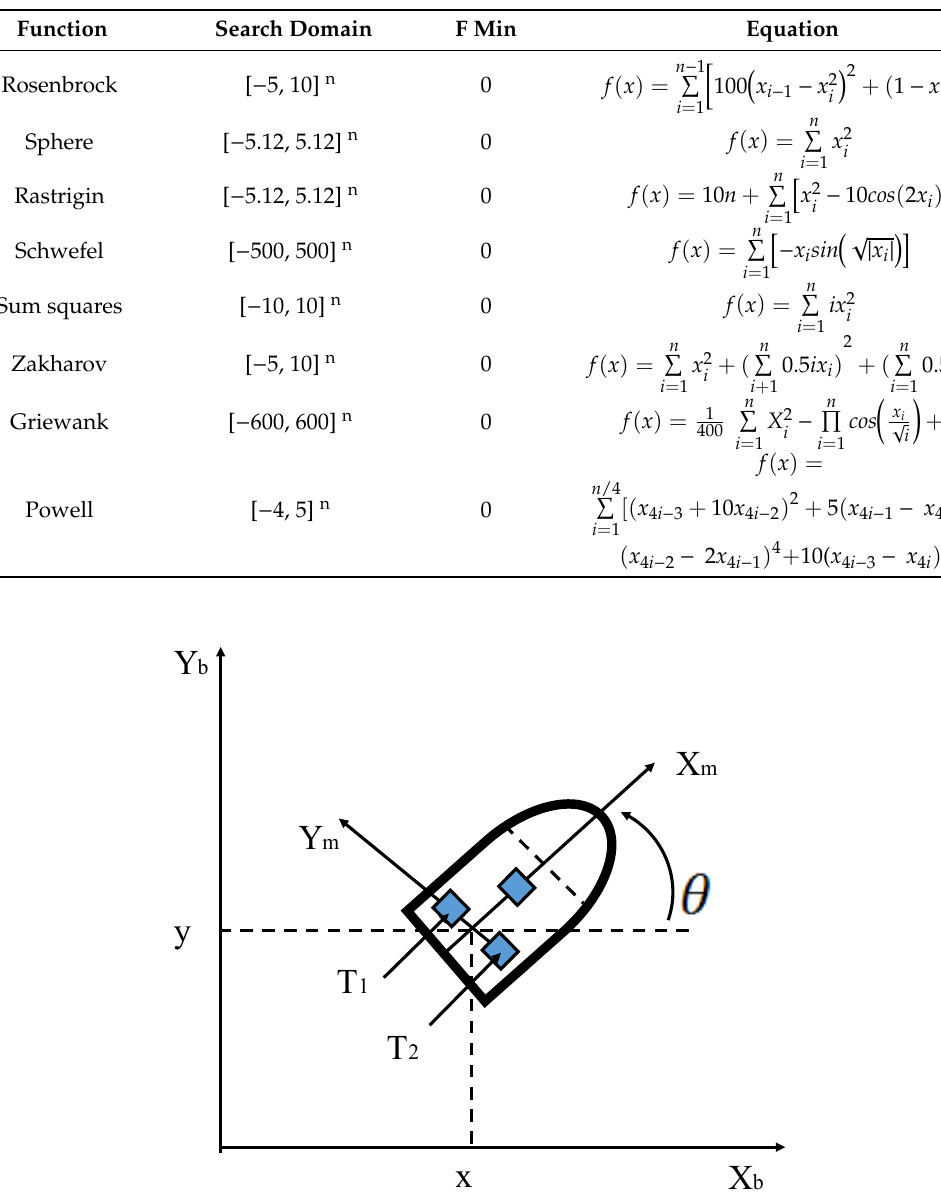
Table 4. Benchmark mathematical functions.